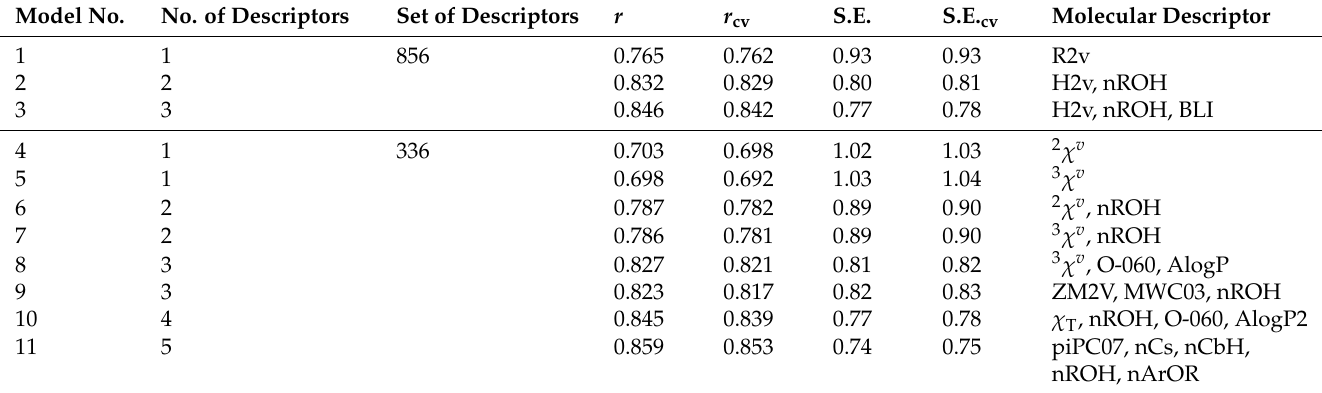
Table 1. Statistical parameters of the best QSAR models using the set of 857 and 336 descriptors for 289 compounds.